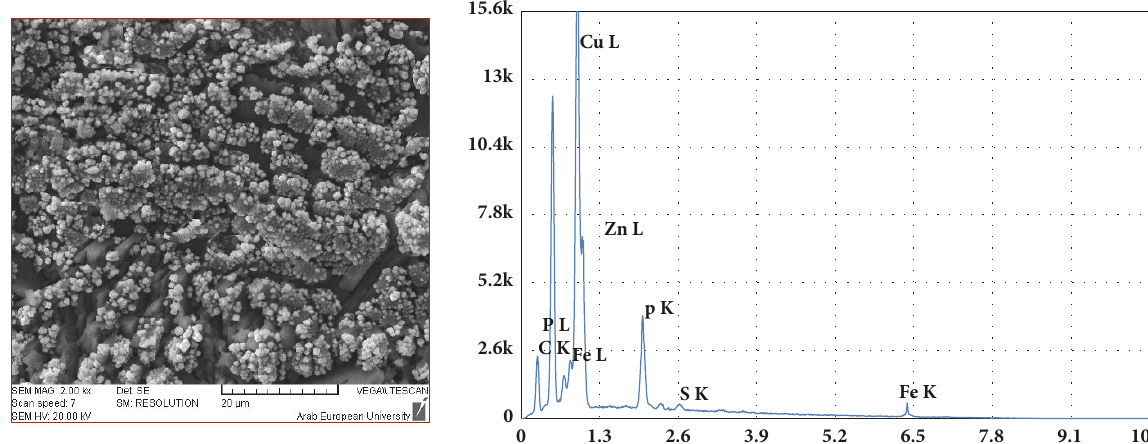
Figure 7: SEM and EDX of ZnP-Cu